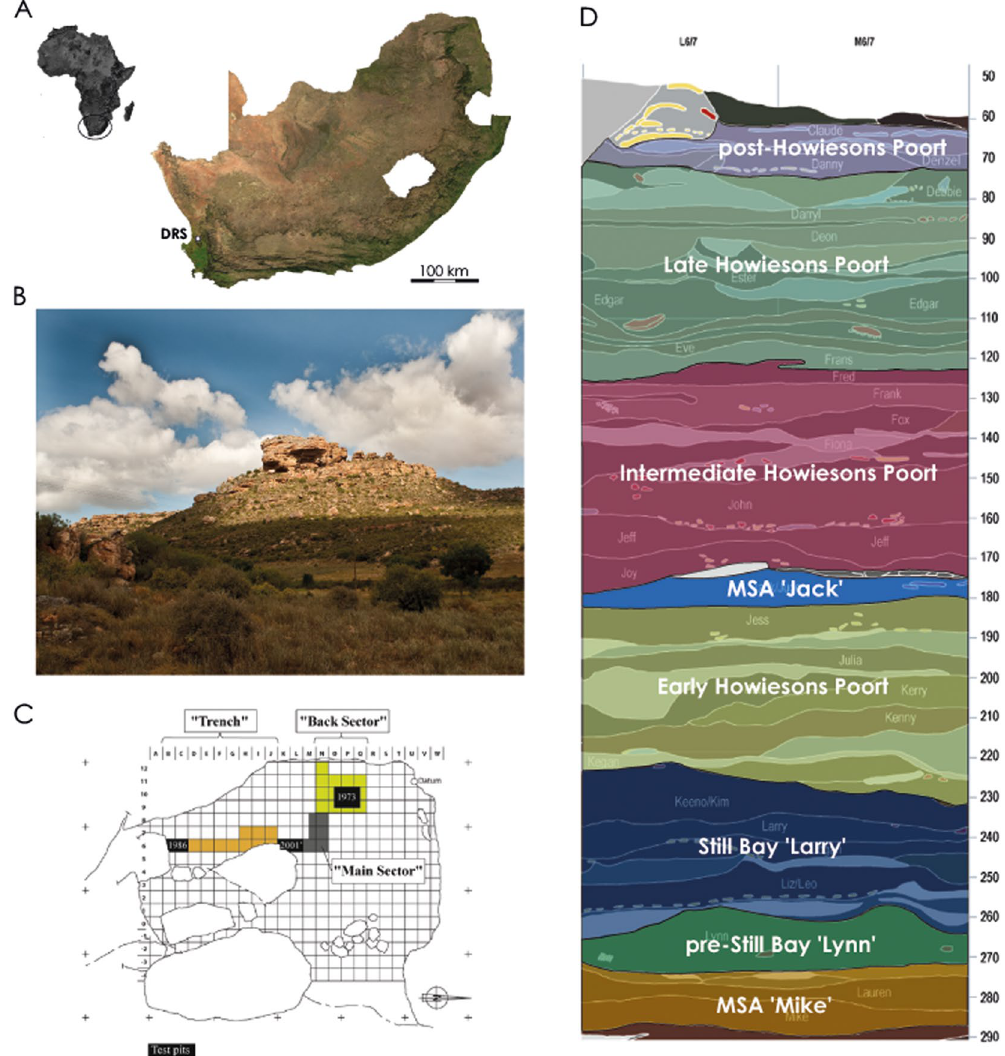
highlighting the different areas of excavation (from 40 ); and ( D ) stratigraphic profile in the main sector, in squares L6/L7 and M6/M7 (simplified after 46